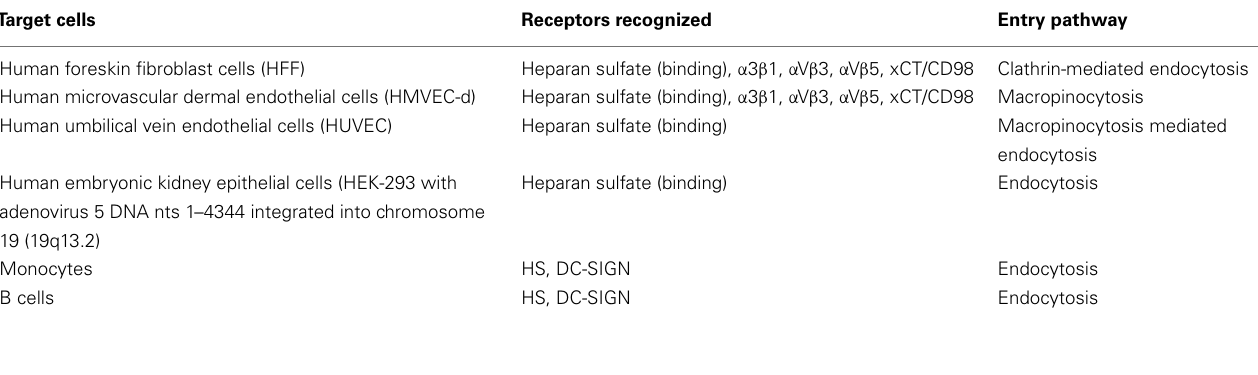
Table 2 | Binding and entry receptors and entry pathways of KSHV in various in vitro human target cells. Target